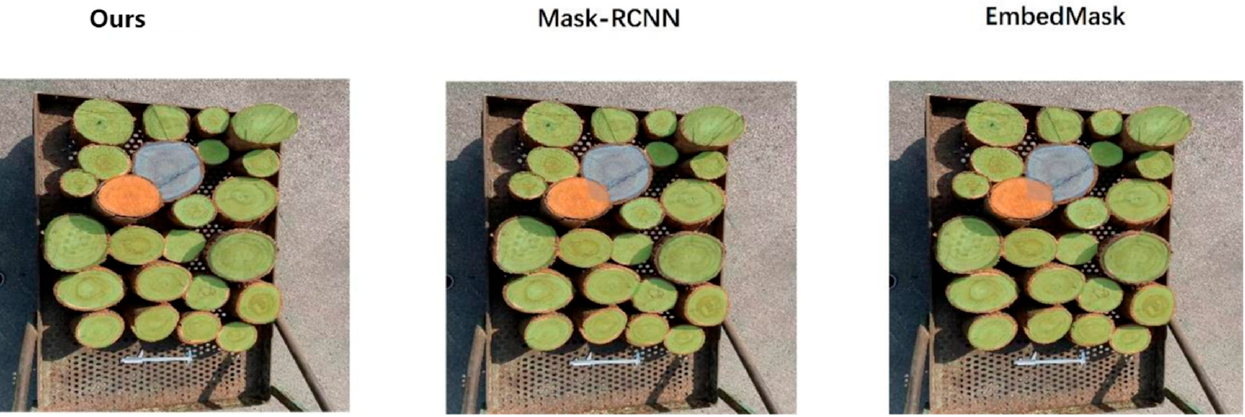
Figure 4. Examples of segmentation results.